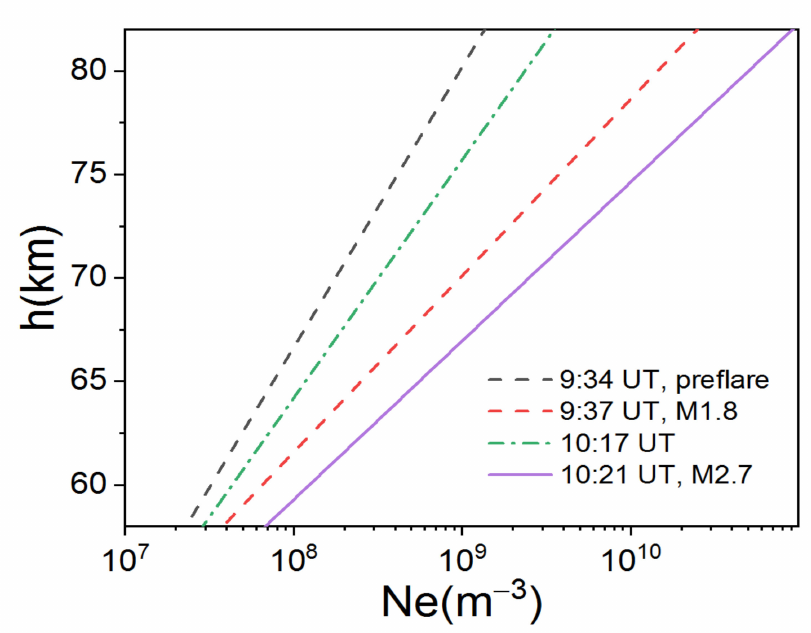
Figure 8. The altitude profile of electron density during two successive M-class SFs on 12 June 2014.